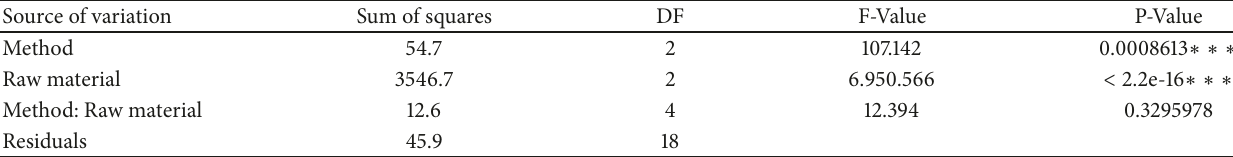
Table 3: Analysis of variance for the percentage of starch depending on the method and the raw material. Source of variation